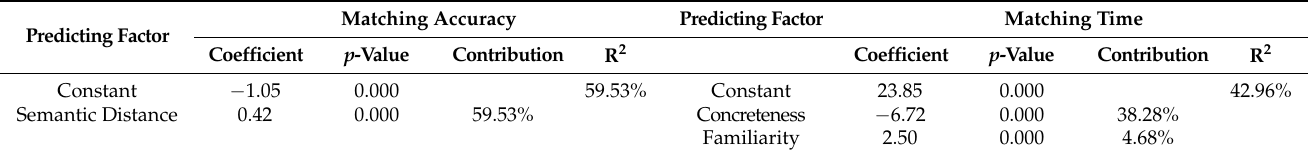
Table 12. Multiple regression analysis for matching accuracy and matching